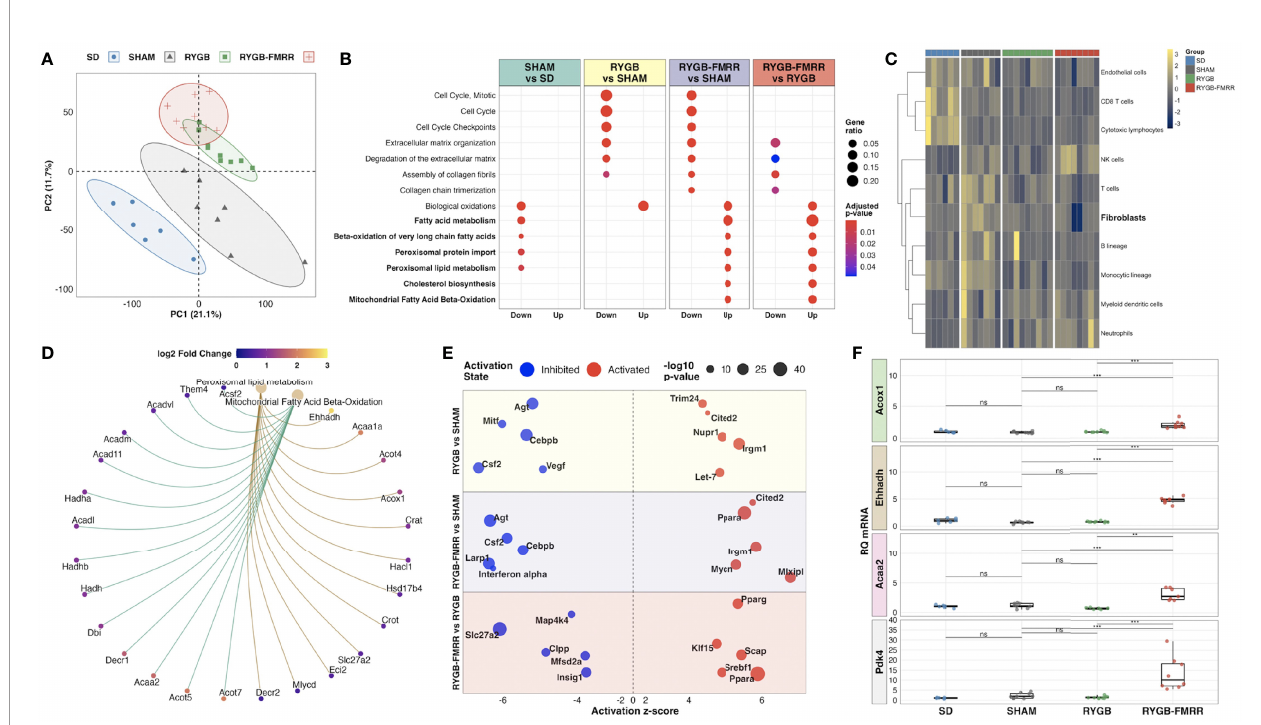
FIGURE 2 | Characterization of renal cortical transcriptomic changes across the experimental groups. (A) Principal component analysis of regularized log- transformed gene expression counts demonstrates renal cortical transcriptomic differences according to group assignment. (B) Dotplot of Reactome pathway over- representation analysis illustrating pathways commonly changed by both RYGB and RYGB-FMRR, and those uniquely changed by RYGB-FMRR (50). Dot colour represents the adjusted p-value for pathway enrichment while dot size is scaled by the gene ratio. Pathways pertaining to fatty acid metabolism are bolded. (C) Heatmap visualization of abundance estimates of eight immune and two stromal cell populations obtained using the Microenvironment Cell Populations-counter (MCP-counter) R package (54). Cell abundance estimates were centred and scaled by heatmap row. Each heatmap row displays abundance of a different cell population. Heatmap columns correspond to individual rats. Gaps between columns as well as the column annotations demarcate the four experimental groups from left to right: SD (blue), SHAM (grey), RYGB (green), and RYGB-FMRR (red). Colouring of heatmap cells re fl ects relative cell abundance between rats: navy = low relative abundance, yellow = high relative abundance. (D) Circular network plot of two fatty acid metabolism pathways uniquely changed by RYGB-FMRR (51). Pathways are represented by the brown nodes at the top of the network. Gene nodes are connected to the brown pathway nodes by coloured edges (gold = peroxisomal; green = mitochondrial). Individual gene nodes are coloured according to magnitude of log2 fold change in transcript abundance in the RYGB-FMRR group relative to the RYGB group. (E) Bubble plot of predicted upstream regulators of gene expression changes (Ingenuity Pathway Analysis) (52). Upstream regulator changes are presented for 3 comparisons: RYGB vs SHAM, RYGB-FMRR vs SHAM, and RYGB-FMRR vs RYGB. The predicted status (inhibited or activated) of upstream regulators is plotted according to z-score. Dot size is scaled to re fl ect the statistical signi fi cance of z-score changes. (F) Quantitative reverse- transcription PCR validation of renal cortical expression changes in three PPAR a -responsive transcripts, both peroxisomal ( Acox1 , Ehhadh ) and mitochondrial ( Acaa2 ), as well as the mitochondrial enzyme Pdk4 , which is a sensitive transcriptional marker of FAO induction. The full data range in each group is captured in boxplots, with gene expression levels of individual constituent samples superimposed. Statistical signi fi cance of between-group differences derived from multiplicity- corrected Wilcoxon rank-sum tests is presented. Statistical signi fi cance is denoted as follows: ns = not signi fi cant; * = p <0.05; ** = p <0.01; *** = p <0.001; **** =